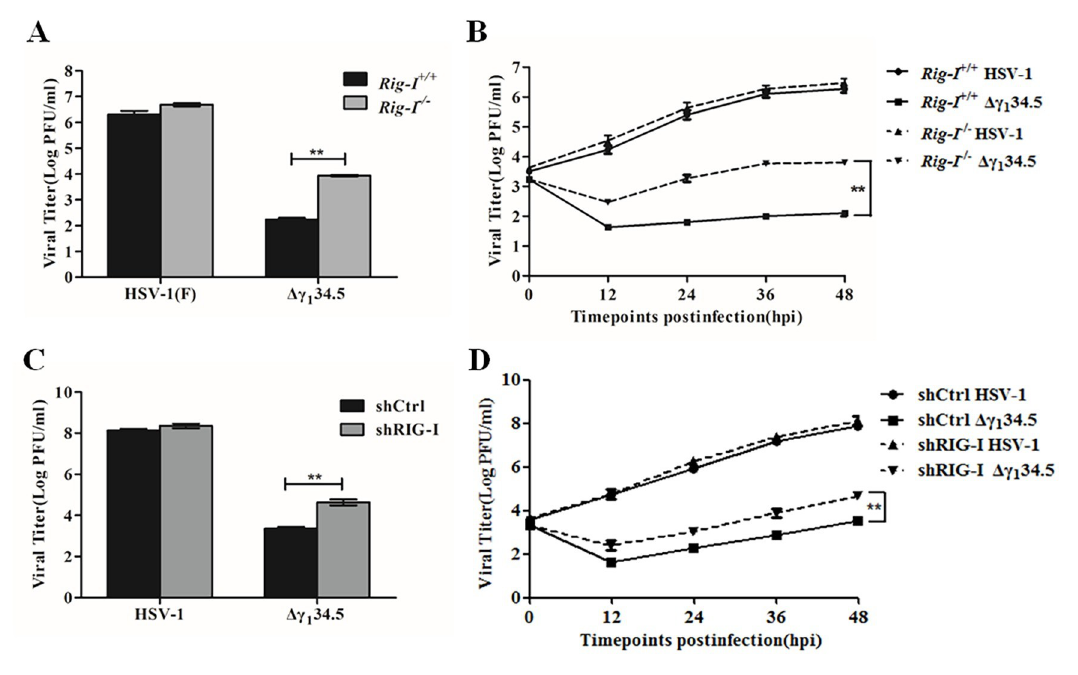
Fig 8. The γ 1 34.5-RIG-I interaction influences HSV-1 replication. (A) Viral replication in Rig-I +/+ or Rig-I -/- MEFs. Cells were infected with wild-type HSV-1 or the γ 1 34.5 deletion virus ( Δγ 1 34.5) at a MOI 0.01. At 48 h postinfection, virus yields were determined on Vero cells by plaque assay. (B) Kinetics of viral growth in Rig-I +/+ or Rig-I -/- MEFs. Viral infection was performed as described for panel (A) and viral yields were measured at the indicated time points. (C) Viral replication in control and RIG-I knockdown human lung fibroblasts cells. shCtrl (control) or shRIG-I (RIG-I knockdown) HEL cells were infected with wild type HSV-1 or Δγ 1 34.5 (0.01 pfu/cell). At 48 h postinfection, virus yields were determined by plaque assay. (D) Kinetics of viral growth in control and RIG-I knockdown cells. Viral infection was performed as described in panel (C) and viral yields were measured at the indicated time points. The data are representative of results from three experiments with triplicate samples. Differences between the selected groups were statistically assessed by one-way ANOVA (A and C) or a two-tailed Student’s t test (B and D) ( �� , P < 0.01).